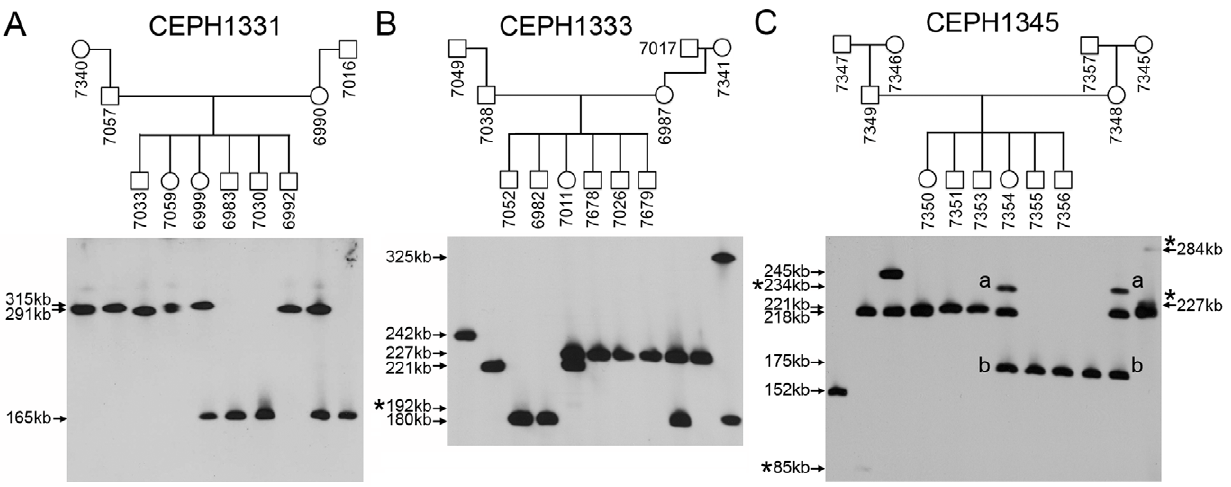
Figure 4. DXZ4 inheritance and stability. Inheritance of DXZ4 through three generations in three independent CEPH Utah pedigrees. (A) CEPH- 1331, (B) CEPH-1333 and (C) CEPH-1345. Members of each family are indicated above the blot in the pedigrees and the members are given the Coriell GM0- ID for each member of the family. Hybridizing fragments are given to the left and right sides of the blots. The asterisks indicate alleles of altered size.